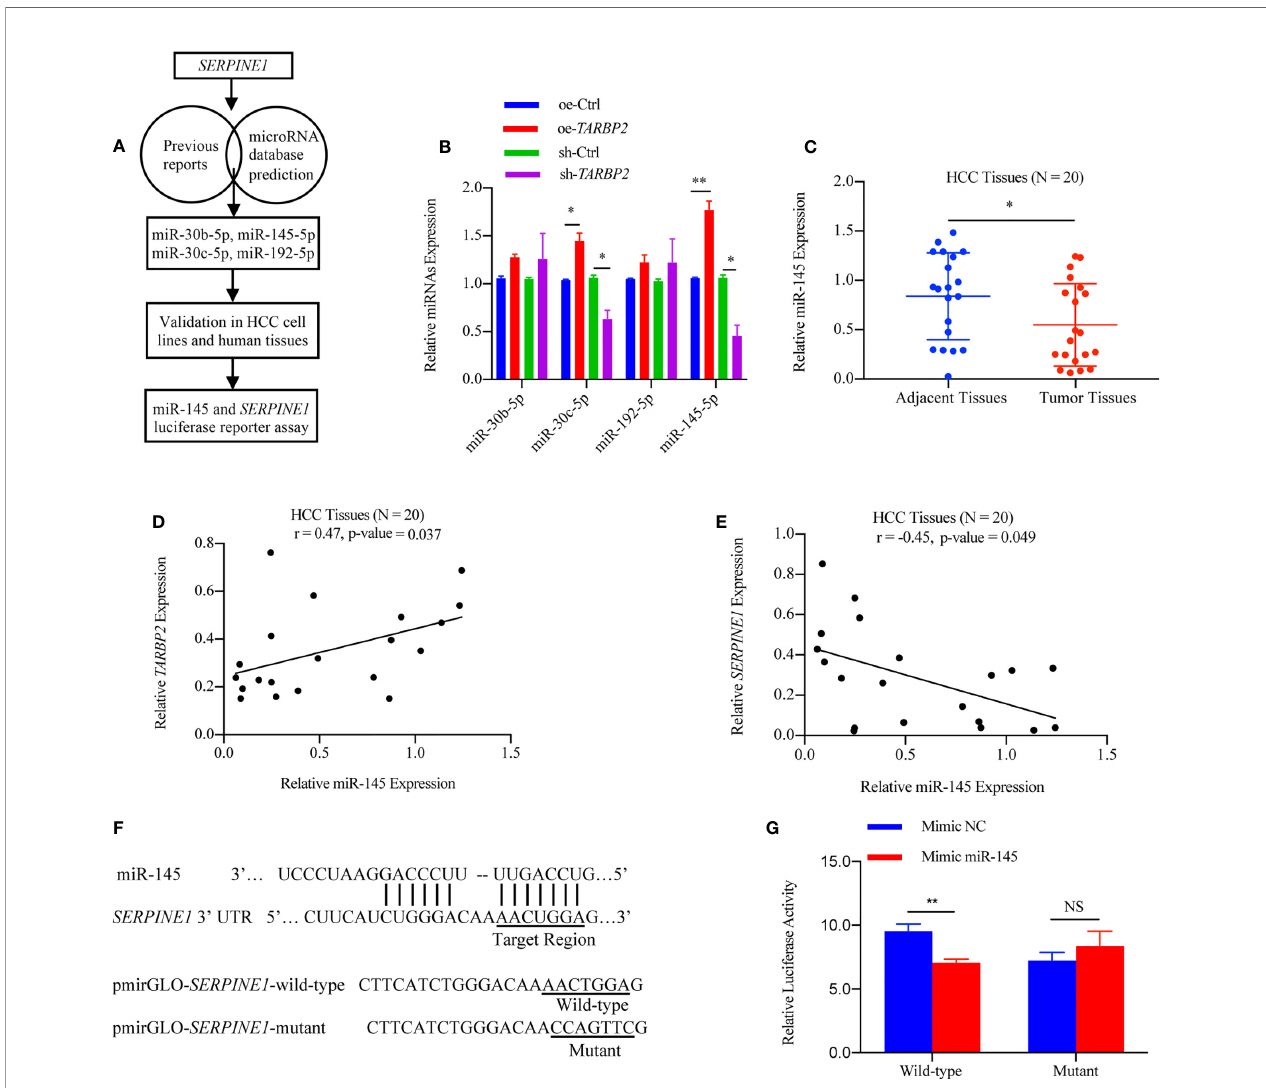
FIGURE 6 | SERPINE1 mRNA is a target of miRNA-145 linked to TARBP2 . (A) Flow chart of selection and analysis of potential miRNAs. (B) Levels of 4 potential miRNAs in the oe/sh- TARBP2 HepG2 cells. (C) Comparison of miR-145 expression between HCC tumors and tumor adjacent tissues (N = 20) (paired t-test p-value = 0.038). (D, E) miR-145 levels in HCC tumors are positively associated with TARBP2 (Pearson r = 0.47, p-value = 0.037) and negatively associated with SERPINE1 (Pearson r = -0.45, p-value = 0.049) (N=20). (F) The binding sites of miR-145 in the 3 ’ -UTR of SERPINE1 mRNA. (G) The effects of miR-145 on reporters, pmirGLO- SERPINE1 -wild-type and pmirGLO- SERPINE1 -mutant, were measured by luciferase reporter assays in HepG2 cells. *p-value < 0.05; **p-value < 0.01; NS, no signi fi cance; NC, negative